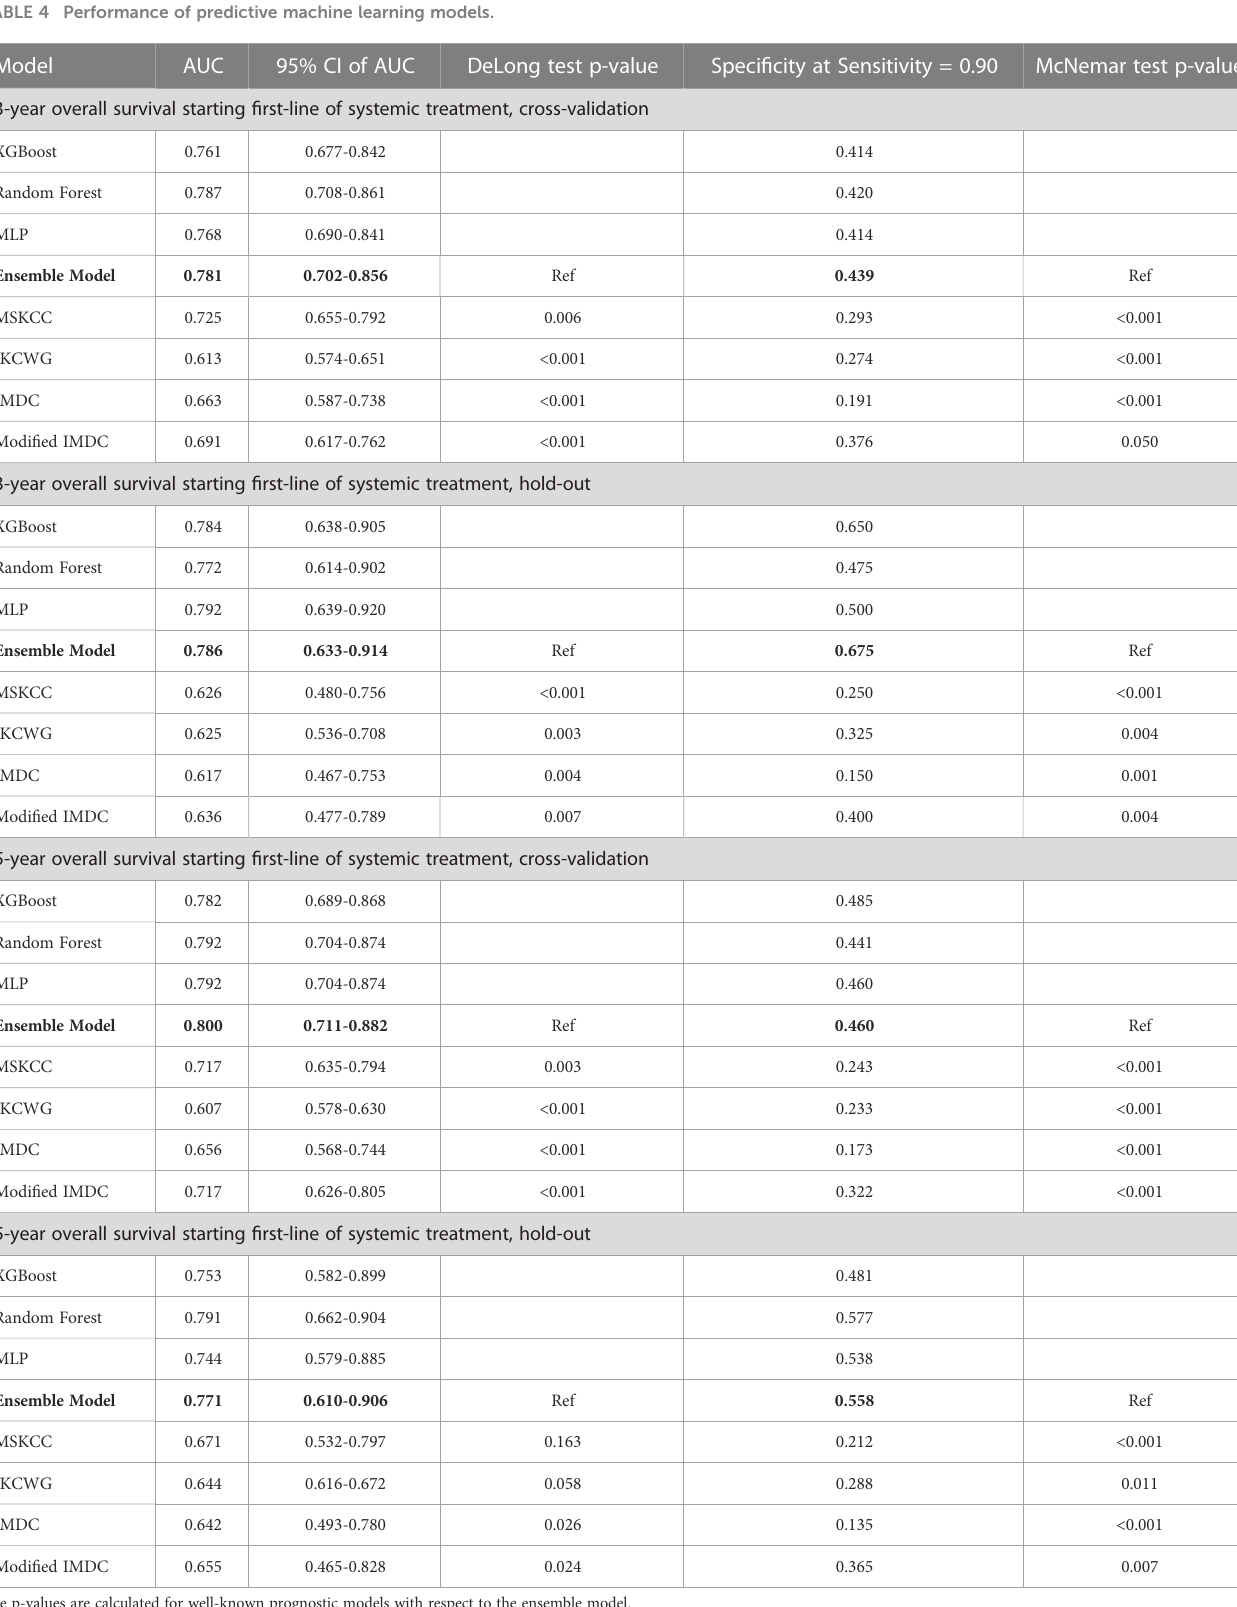
TABLE 4 Performance of predictive machine learning